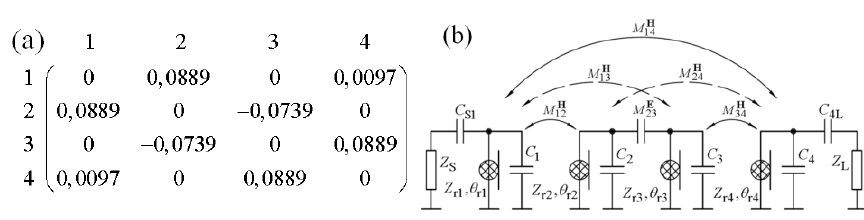
Fig. 4. The coupling matrix of QEF on MCB with classical topology (a) and its equivalent circuit (b). As can be seen from the obtained coupling matrix and equivalent circuit, in order to obtain two attenuation poles near the passband (normalized passband frequencies are ± j 2.55) in the classical topology, it is required to provide magnetic coupling between the first and fourth resonators. The cross-couplings indicated by the dashed line are negligible and make an insignificant contribution to the shape of the frequency response, so at this stage they are equal to